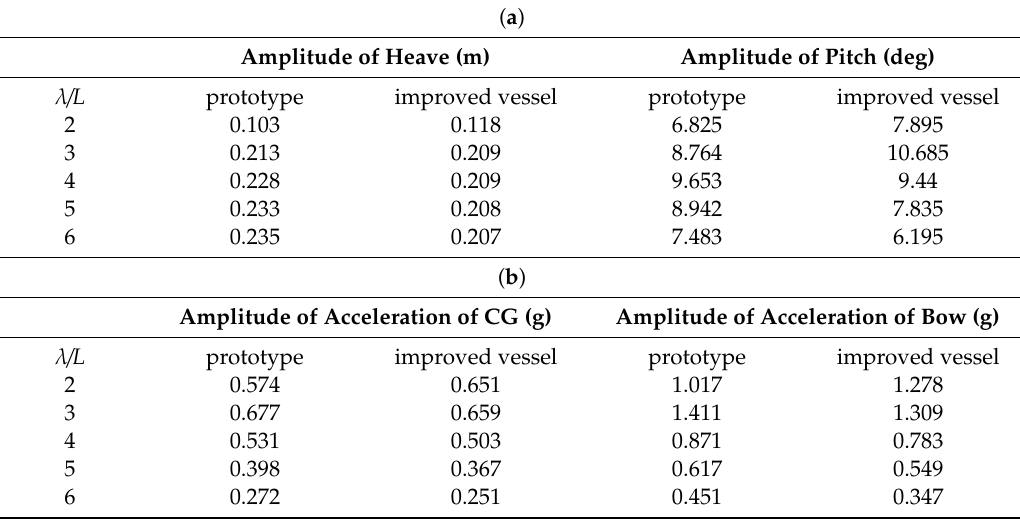
Table 12. RAOs of the prototype and improved vessel: ( a ) Heave and pitch; ( b ) Acceleration